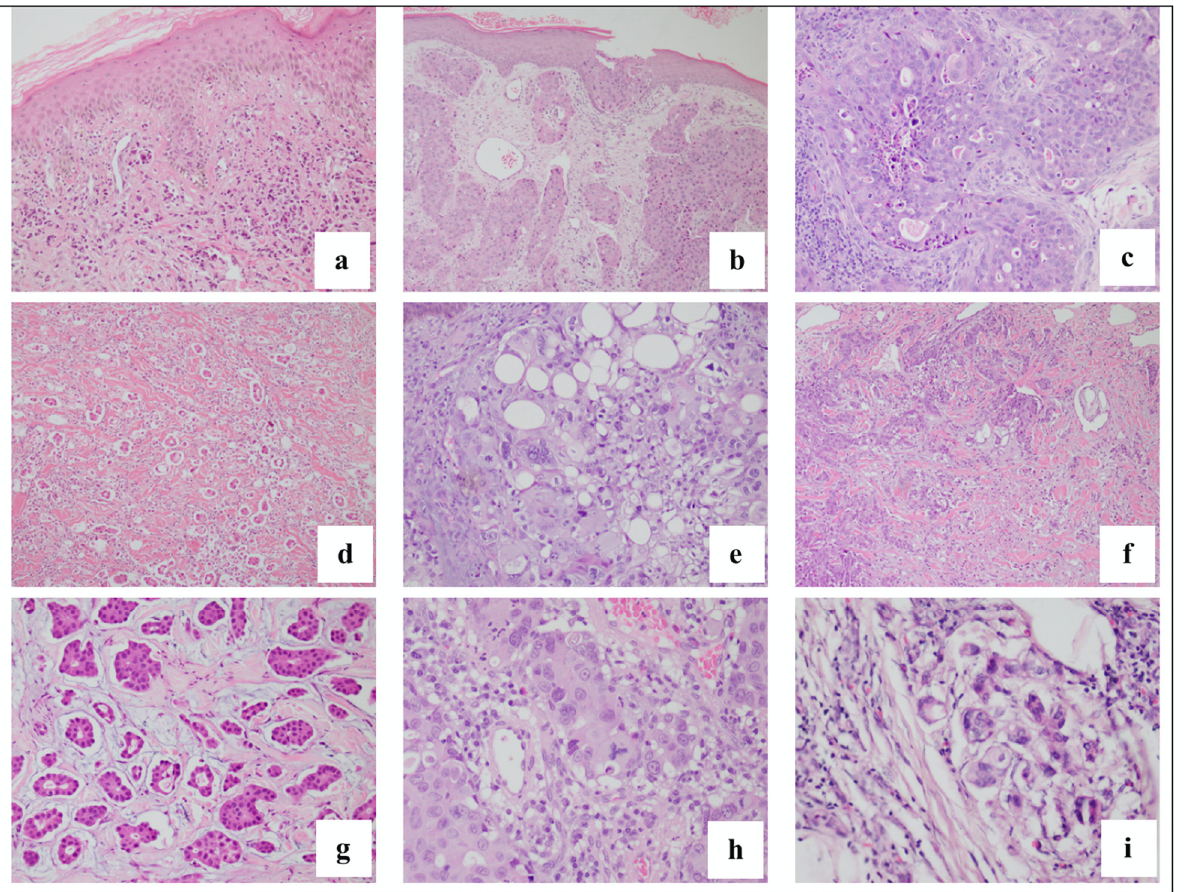
Figure 5. Histologic features seen in this study. ( a ) Epidermotropism seen in case 1302, from breast adenocarcinoma (20×). ( b ) Necrosis and ulceration in a case of breast adenocarcinoma, 1818 (40×). ( c ) Tumor necrosis in a case of breast adenocarcinoma, case 1708 (40×). ( d ) Atypical cells interspersed between collagen bundles, and within vascular spaces resembling florets, seen in the entire dermis (20×). ( e ) Atypical pleomorphic cells with high mitotic index seen in case 1701, from a case with unknown primary malignancy (40×). ( f ) Hints of mucin and sclerotic stroma seen in a case of colorectal adenocarcinoma, case 1807 (20×). ( g ) Wisps of mucin surrounding tumor cells in a case of breast adenocarcinoma, case 1818 (40×). ( h ) Mixed cell infiltrate showing lymphocytes, neutrophils, eosinophils and plasma cells, in a case with unkown primary malignancy, case 1828 (40×). ( i ) Signet ring cells seen in a a case of breast adenocarcinoma, case 1706 (40×).